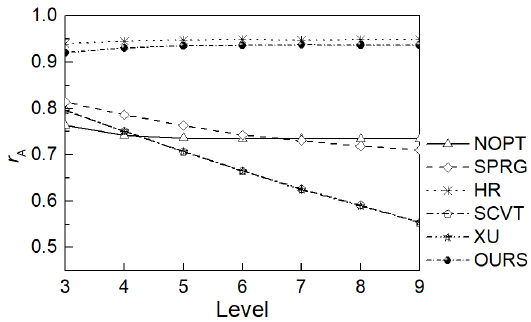
Figure 6. Ratios between A min and A max of different grids. The maximum grid area, minimum grid area and their ratios indicate the ranges of grid area. The closer the ratio is to one, the smaller the area range is, which indicates a more uniform grid area. The normalized minimum and maximum areas of all grids except the SCVT grid and XU grid gradually have converged as the resolution increases (Figures 5 and 6 and Tables 1 and 2). The area range of SCVT grid and XU grid are the same and the biggest among all grids at level 9. The one of NOPT grid is followed and that of HR grid is the smallest. The range of OURS grid is only expanded by 1.20% compared with HR grid. Same as the range, ratios of SCVT grid and XU grid are non ‐ convergence as resolution increases and have decreased to 0.554 and 0.555 at level 9, respectively. The ratios of SPRG grid and NOPT grid have converged slowly to 0.711 and 0.734, respectively. On the contrary, the ones of HR grid and OURS grid have increased as resolution increases and converged to 0.950 and 0.937, respectively at the same resolution.